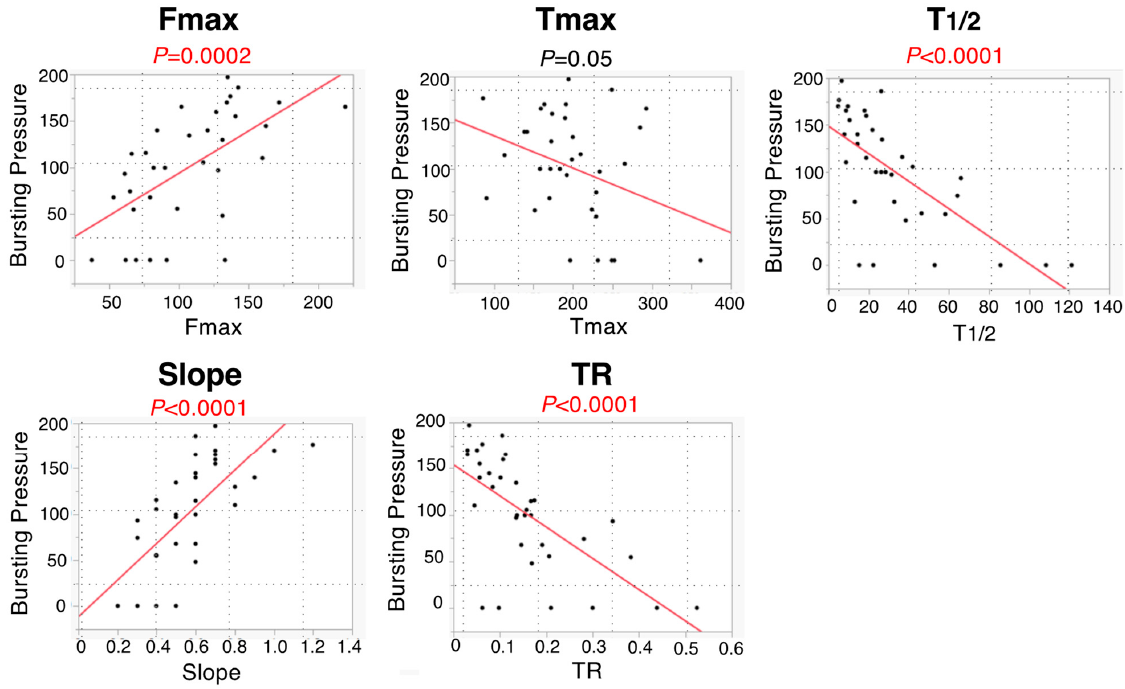
Figure 7. Prediction of AL by receiver operating characteristic (ROC) curve. For continuous variables related to bursting pressure and colonic blood flow, a sig- analysis ( p = 0.0002, <0.0001, <0.0001, and <0.0001, respectively) (Figure 8).